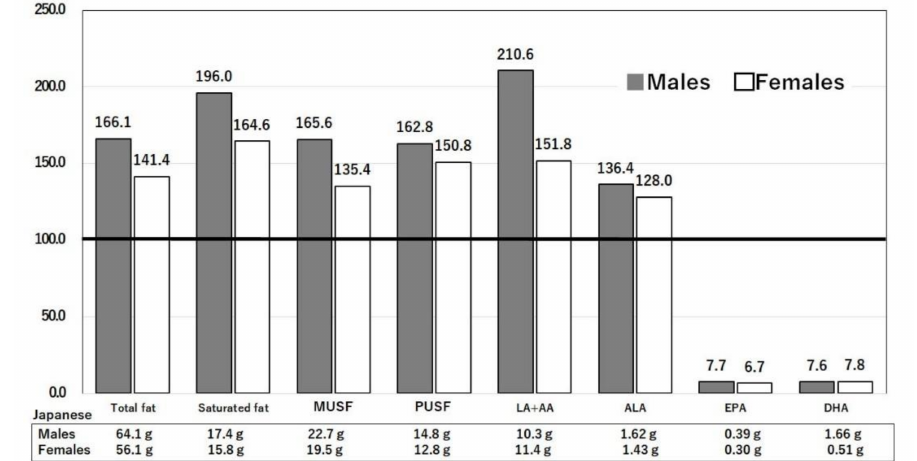
Figure 5. Ratios of lipid intakes in the U.S. compared with Japan. Daily intakes of lipids by Japanese men and women were set to 100% and compared with the intakes of American men and women. The actual daily values of Japanese intakes are shown below each bar. The age range is 40–49